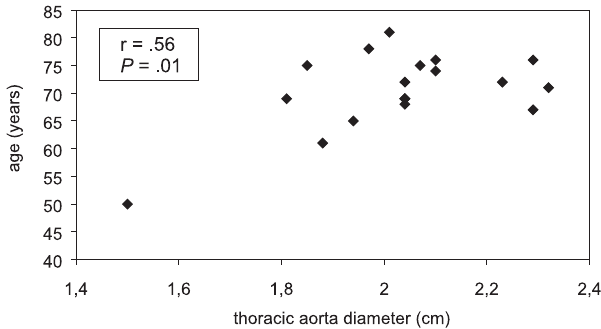
Figure 2 - Scatter plot graph of the diameter of the thoracic aorta versus the age of the patients